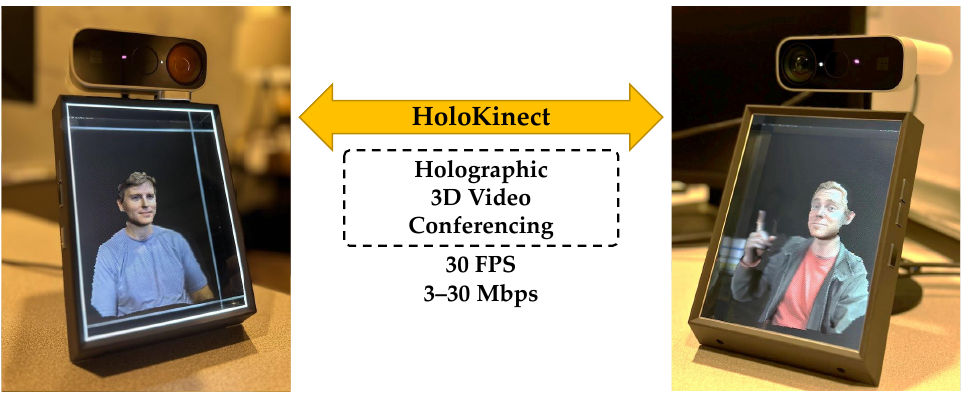
Figure 4. Visualization of a live two-way HoloKinect 3D video call on a pair of Looking Glass Portrait multiscopic displays. The Looking Glass Portrait provides 48 distinct views of the reconstructed 3D mesh, each with a resolution of 420 × 560. The left and right eyes see distinct views, enabling a 3D viewing